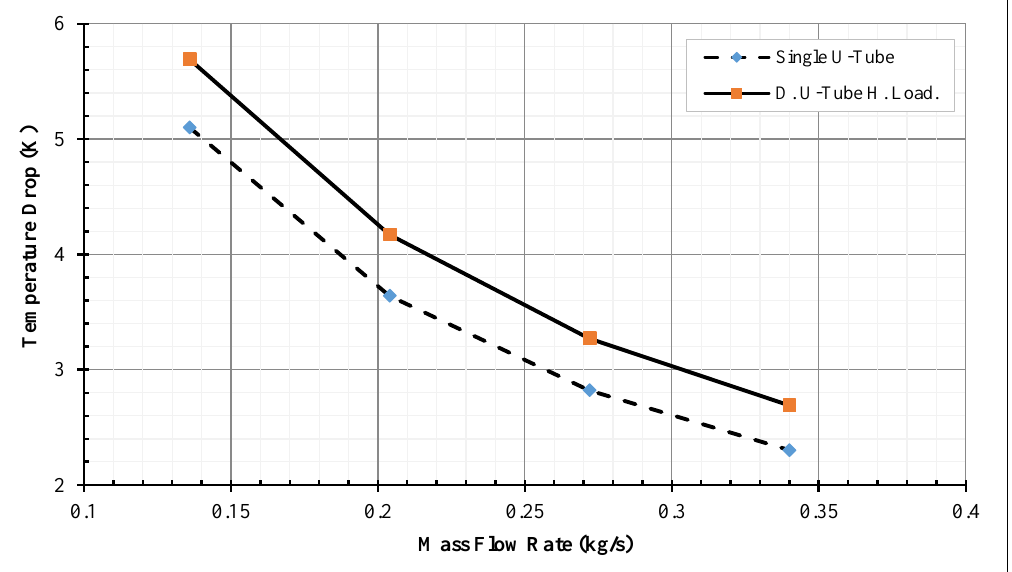
Figure 8. A comparison for the water temperature drop across the single and the half loading double-U-tube heat